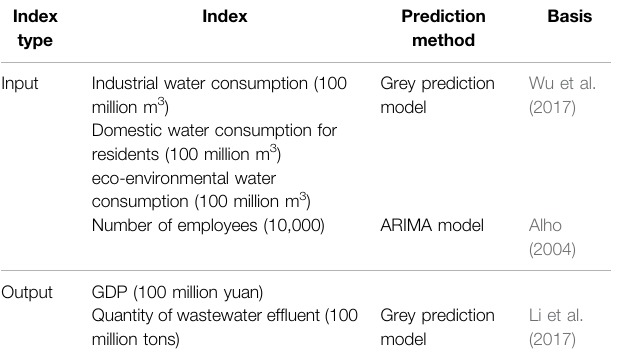
TABLE 2 | Prediction methods and sources of index data.